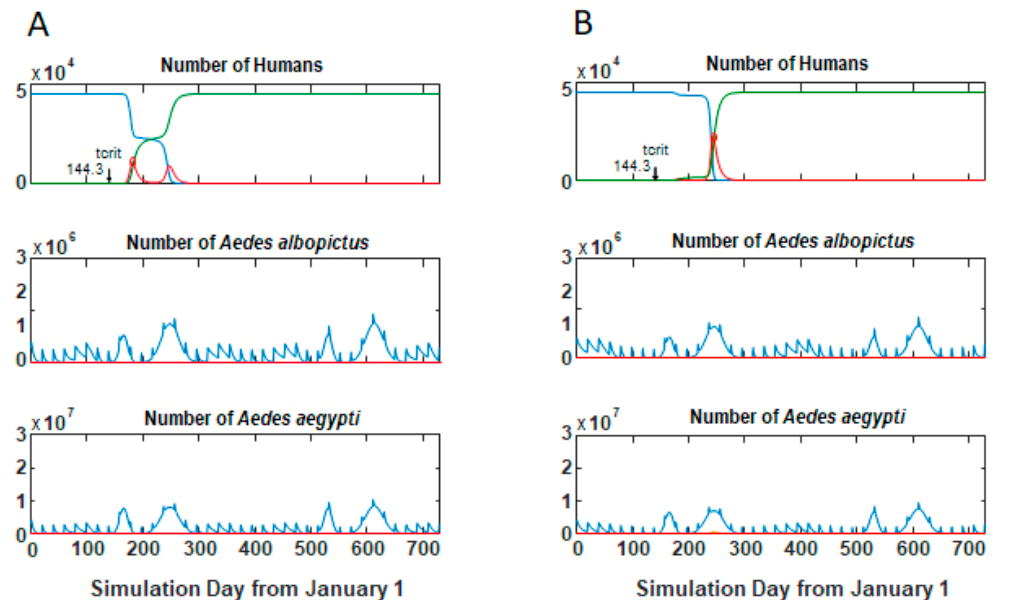
Figure 4. Change in behavior with Temp c . Other parameter values as for Figure 3A. ( A ) Temp c = 16 °C. ( B ) Temp c = 10 °C; compare to Figure 2A. Decreasing Temp c changes model behavior from rapid single